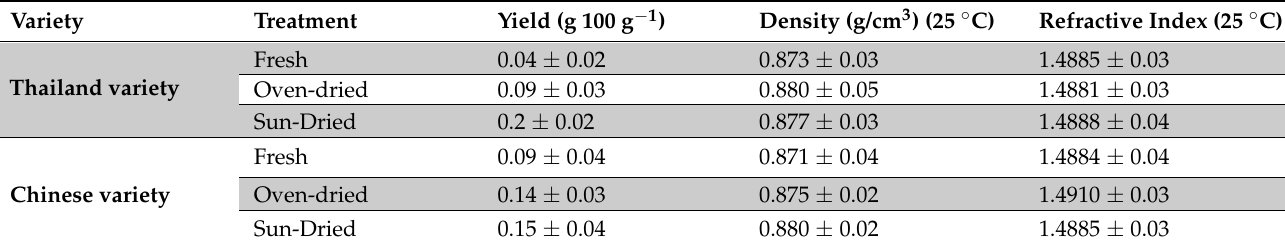
Table 1. Physical properties of Thailand and Chinese ginger essential